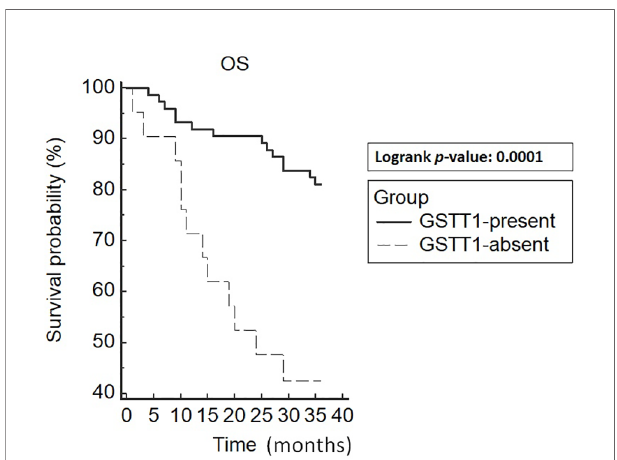
FIGURE 4 | Kaplan-Meier curve demonstrating the overall survival (OS) based on genotypes of GSTT1 . The mean OS was 33 months (95%